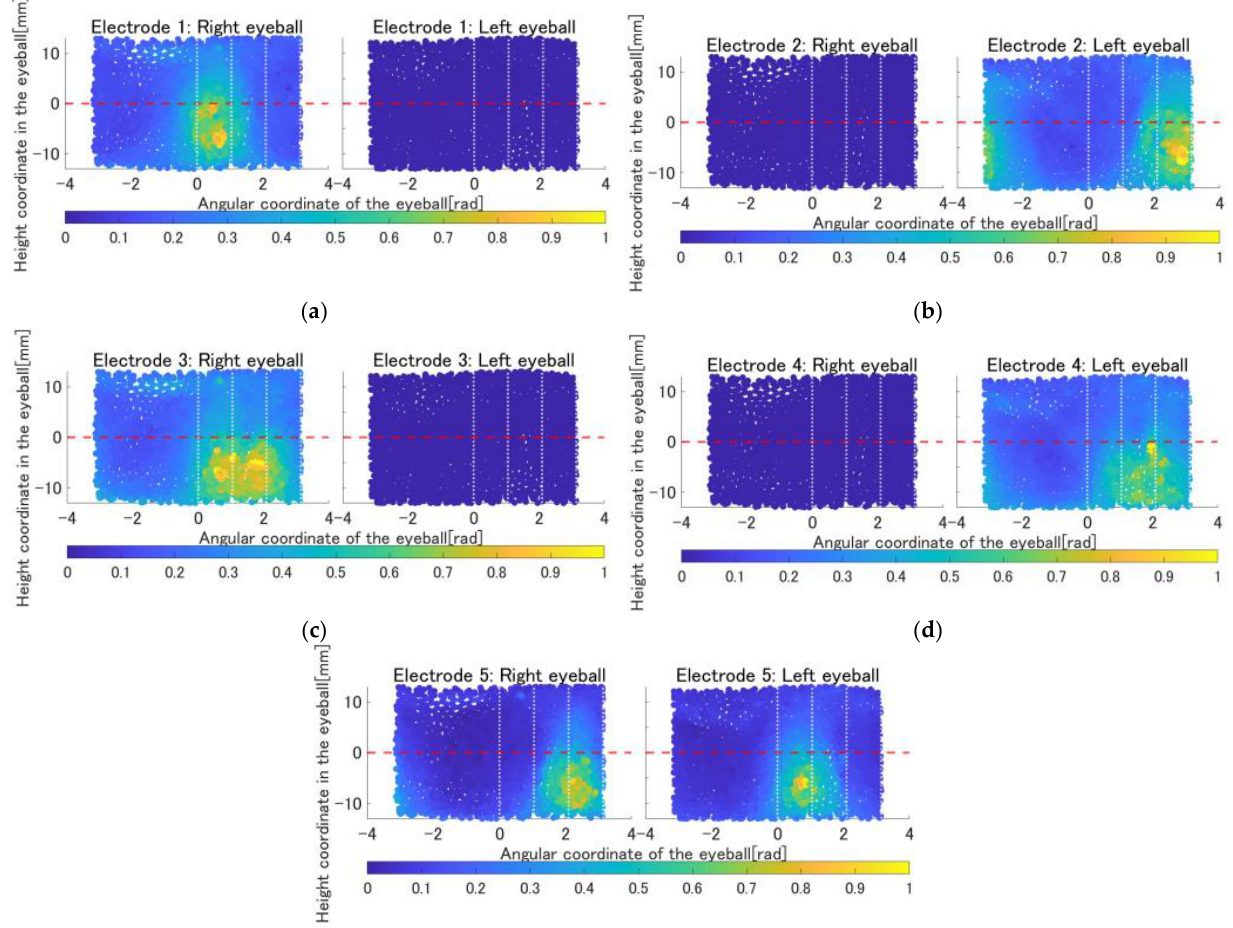
Figure 7. Simulation results with proposed electrodes stimulation the lower side of the eyeball surface: ( a ) simulations results for electrode 1; ( b ) Simulation results for electrode 2; ( c ) simulation results for electrode 3; ( d ) simulation results for electrode 4; ( e ) simulation results for electrode 5.